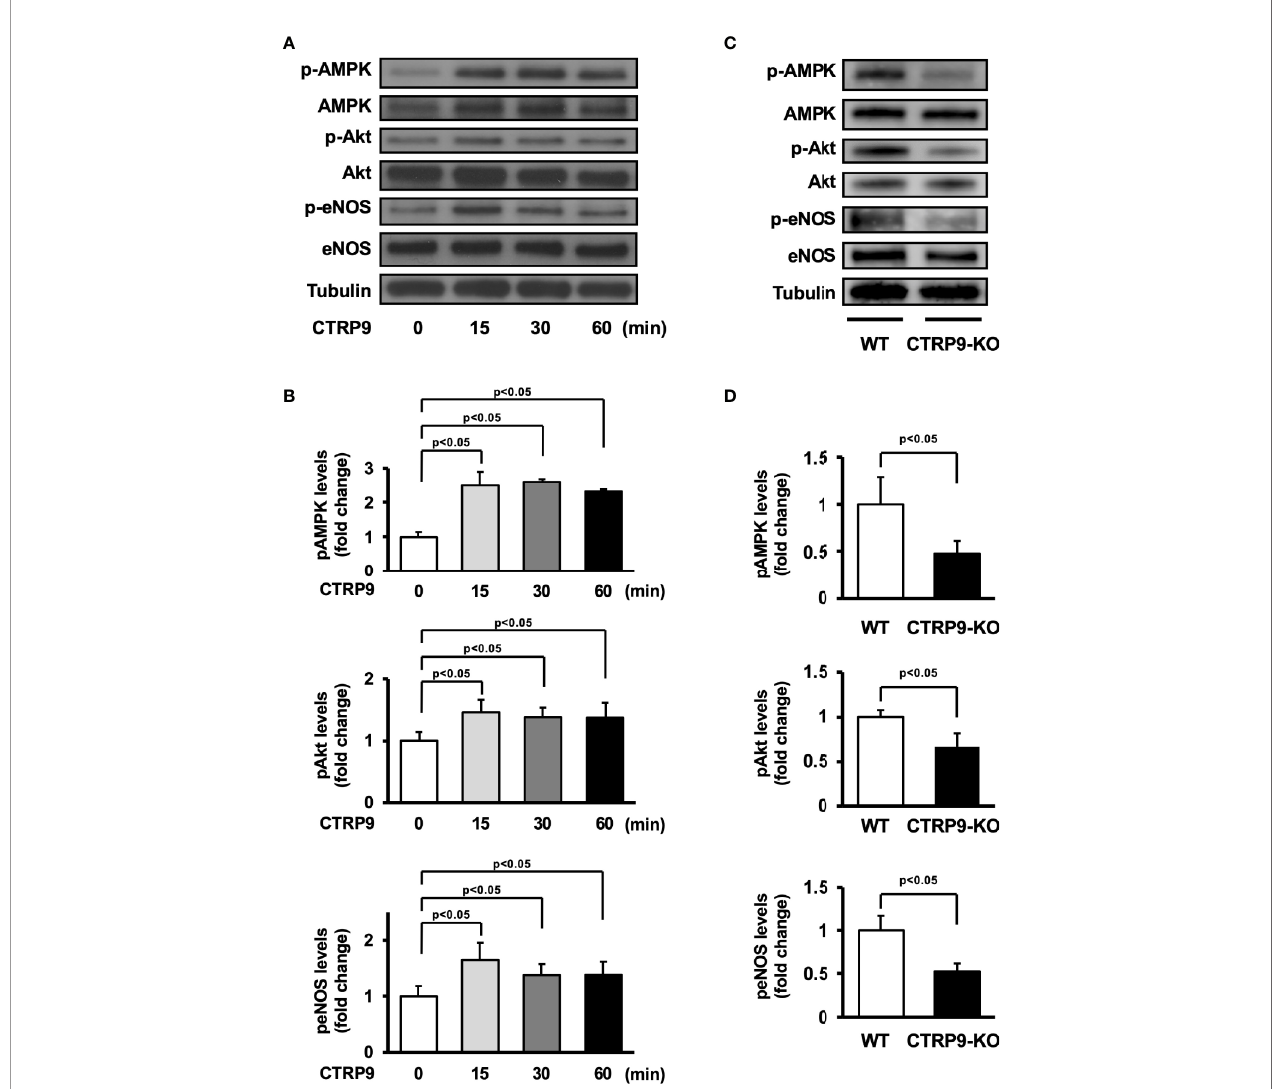
FIGURE 4 | Effect of CTRP9 on the phosphorylation of AMP-activated kinase (AMPK), Akt, and endothelial nitric oxide synthase (eNOS) in endothelial cells and ischemic muscle. (A) Time-dependent changes in the phosphorylation of AMPK, Akt, and eNOS signaling in endothelial cells following stimulation with CTRP9. Changes in the phosphorylation of AMPK (p-AMPK), Akt (p-Akt), and eNOS (p-eNOS) after CTRP9 treatment were determined by Western blot analysis. Representative blots are shown. (B) Quantitative analysis of relative changes in phosphorylated AMPK, Akt, and eNOS in endothelial cells following stimulation with CTRP9 (n = 3 – 4 independent culture experiments). (C) The phosphorylation of AMPK, Akt, and eNOS in the ischemic muscle of WT and CTRP9-KO mice at day 7 after surgery. Phosphorylation of AMPK, Akt, and eNOS was determined by Western blot analysis. (D) Quantitative analysis of relative changes in the phosphoylation of AMPK, Akt, and eNOS in the ischemic muscle of WT and CTRP9-KO mice at day 7 after surgery (n = 3 – 4 mice for each group). Relative phosphorylation levels were normalized to total protein signal. Relative phosphorylation levels of AMPK, Akt, and eNOS were quanti fi ed using ImageJ software. Results are presented as mean ±